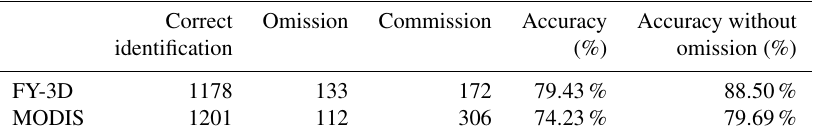
Figure 9. Accuracy assessment of FY-3D fire products in China based on the ground-based reference. Table 8. Accuracy assessment based on field ground